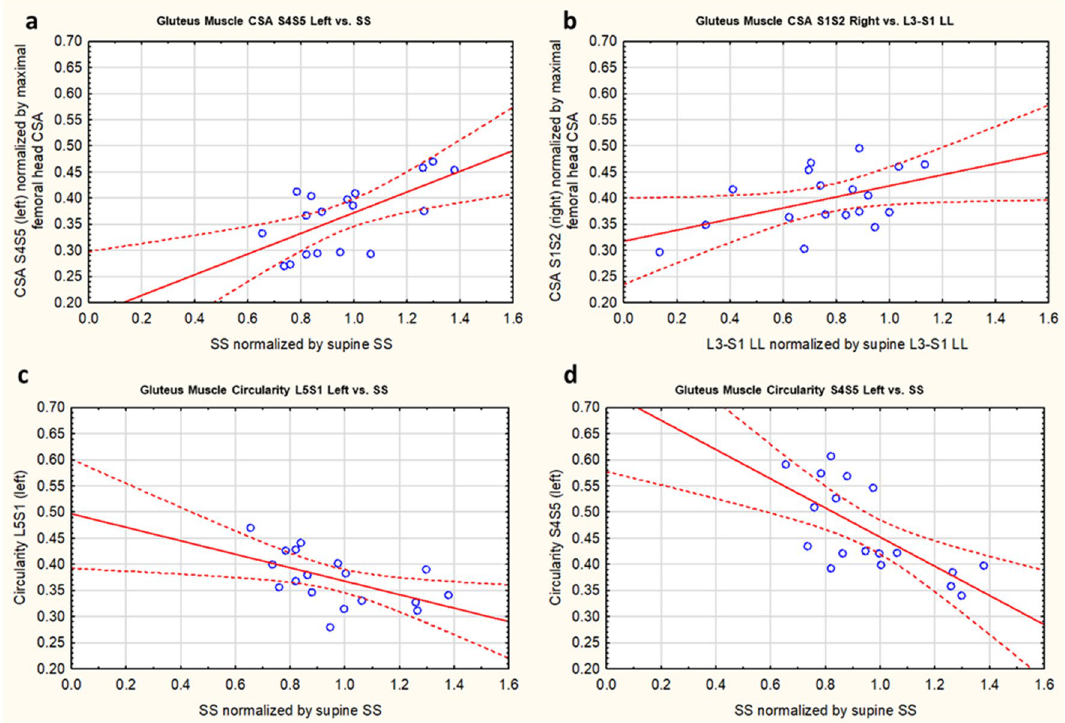
Figure 5. Sample Pearson’s correlation plots of muscle morphometry (CSA and circularity) versus pelvic geometry (SS and L3–S1 LL). CSA was normalized by maximum femoral head cross-sectional area and pelvic geometry (SS and L3–S1 LL) was normalized by supine